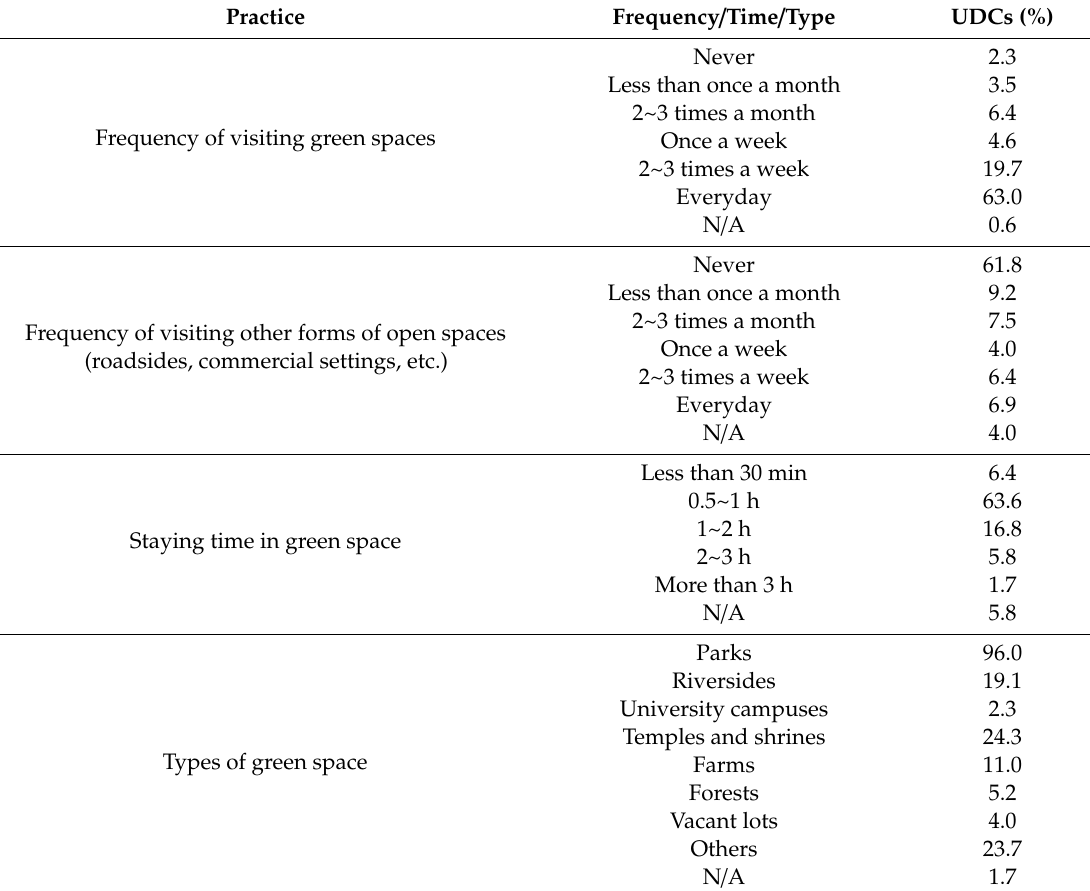
Table 4. Overview of UDC practices around GS